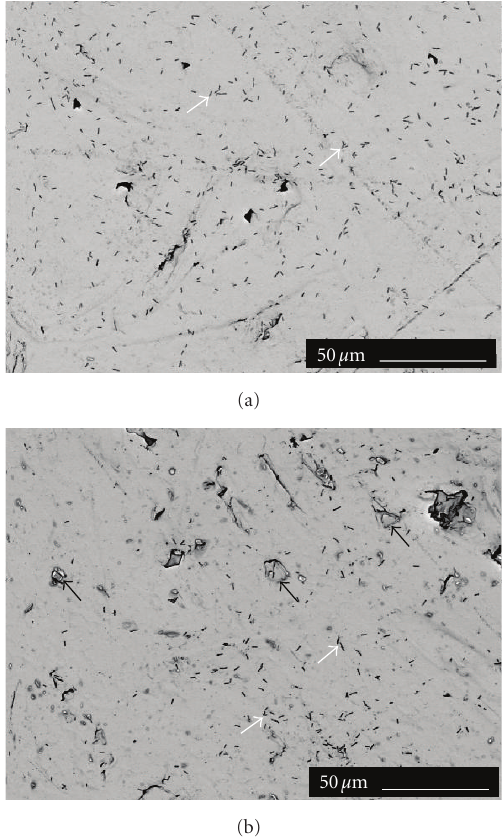
Figure 3: SEM image of the P. aeruginosa (ATCC 27853) attach- ment on the composite (a) and on the C90 disc (b) after 30-minute immersion (white arrows). Bioactive glass granules are visible on the surface of C90 material (black arrows). Images are inverted into negatives to show the attached